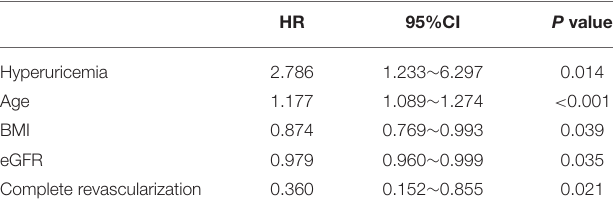
TABLE 3 | Multivariate analysis for all-cause